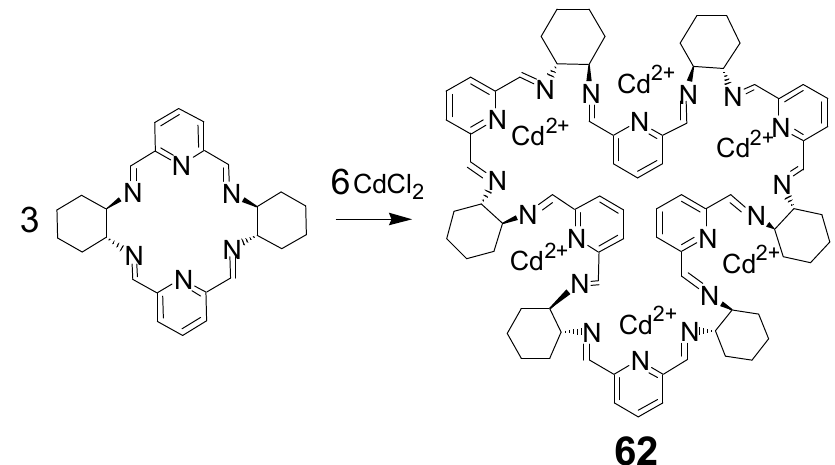
Figure 29. [6 + 6] homochiral macrocycle derived from DACP.